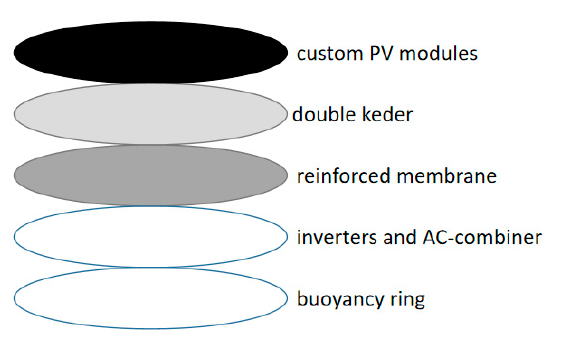
Figure 10. Hybrid offshore platform structure (OHP) [33]. [Permission of using the figure has been requested from the copyright holder SINN POWER].